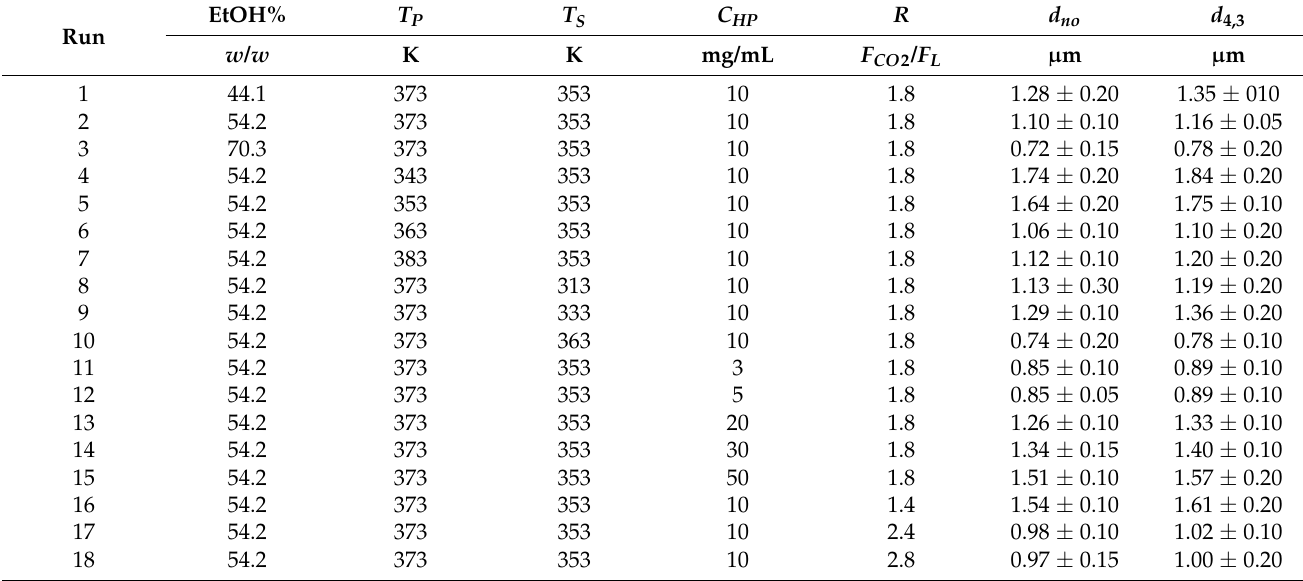
Table 1. Experimental conditions and results of the HP- β -CD particles produced using SAA.